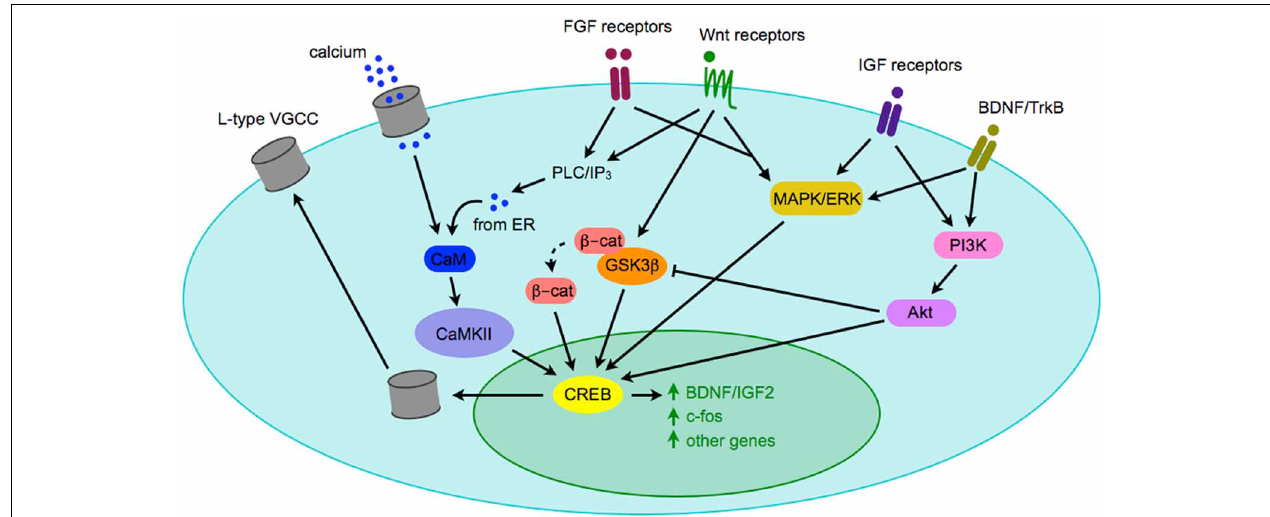
FIGURE 3 | Crosstalk between signaling pathways implicated in pathogenesis of neuropsychiatric diseases. When synaptogenic growth factors bind to their respective receptors, they can trigger a number of intracellular signaling cascades. Depicted here are the PLC/IP3/CAMK pathway, the MAPK/ERK pathway, and the PI3K/Akt pathway. Although there are a number of downstream effectors of each pathway, they may converge on the CREB transcription factor and gene expression, including expression of genes that modify neuronal activity, such as BDNF and the L-type VGCC. Although only one cell is depicted here, the model could apply to a